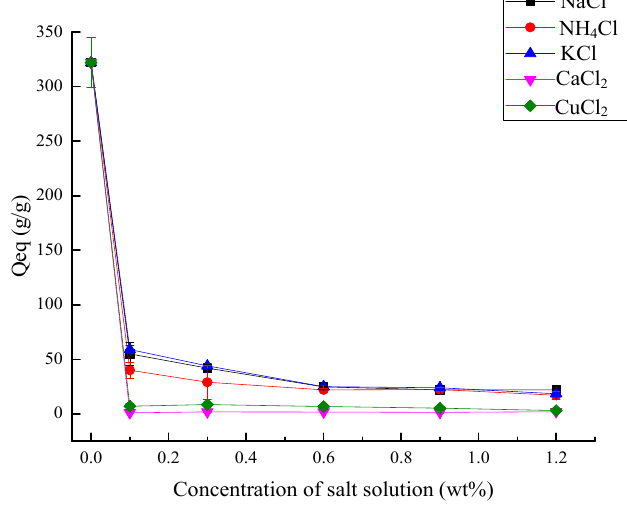
Figure 12. Absorbency ability in different salt solutions.